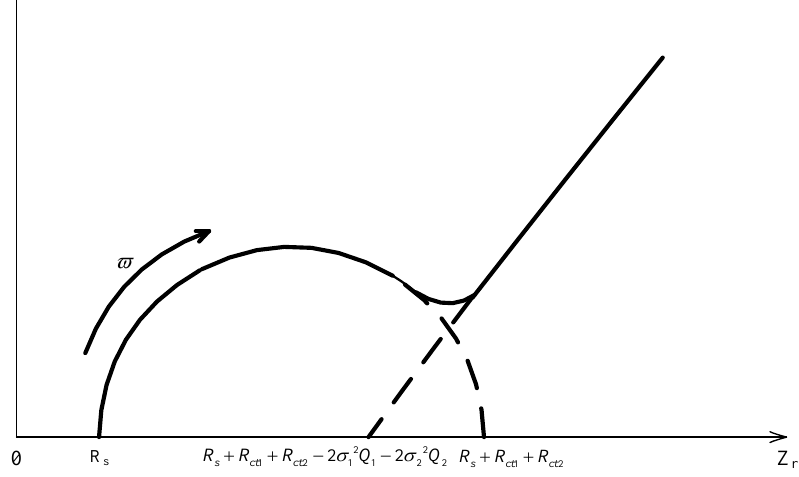
Figure 6. ( a ) The Nyquist plots; ( b ) Bode plots; and ( c ) Phase angle plots of the electrochemical impedance measurement for mortar with 1:3 cement/sand ratio at 21 day carbonation. The experiment data are shown as open circles. The dotted line is the fitting results based on R ( Q ( R W )) model and the solid line is the fitting results based on s ct R ( Q R )( Q R ) model, together with the dots which represents the s 1 ct1 2 ct2